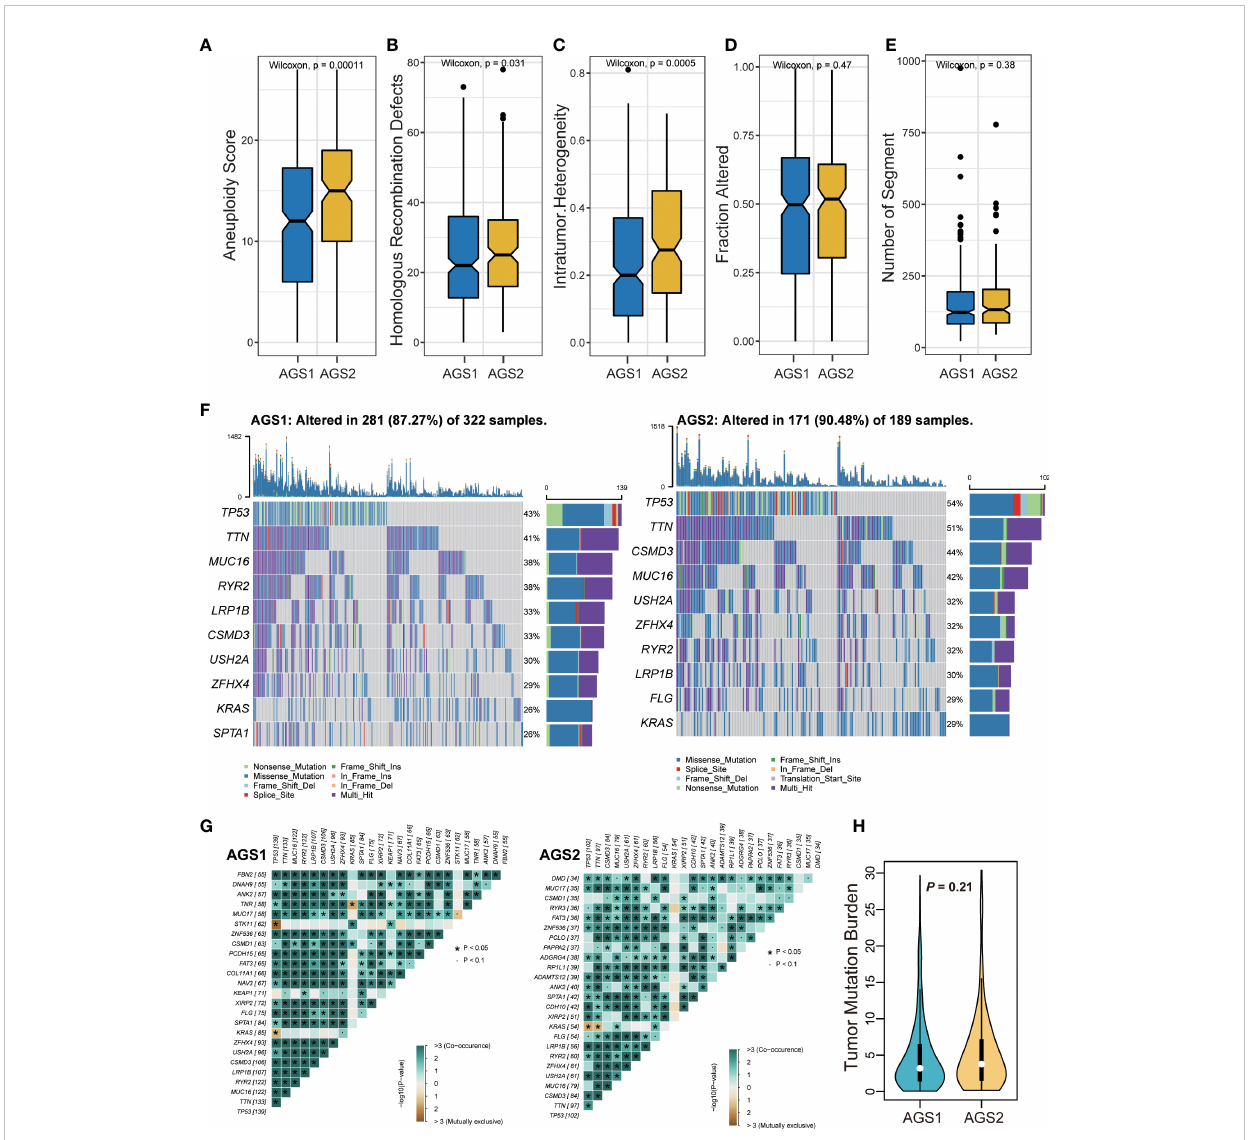
FIGURE 3 The genomic landscape of AGS clusters. (A-E) Measures of DNA damage, (A) aneuploidy score, (B) homologous recombination defects, (C) intratumor heterogeneity, (D) Fraction altered, and (E) number of segments between AGS1 and AGS2. (F) The mutation spectrum of two clusters. (G) The mutation correlation of two clusters. (H) The violin plot of tumor mutation burden between AGS1 and